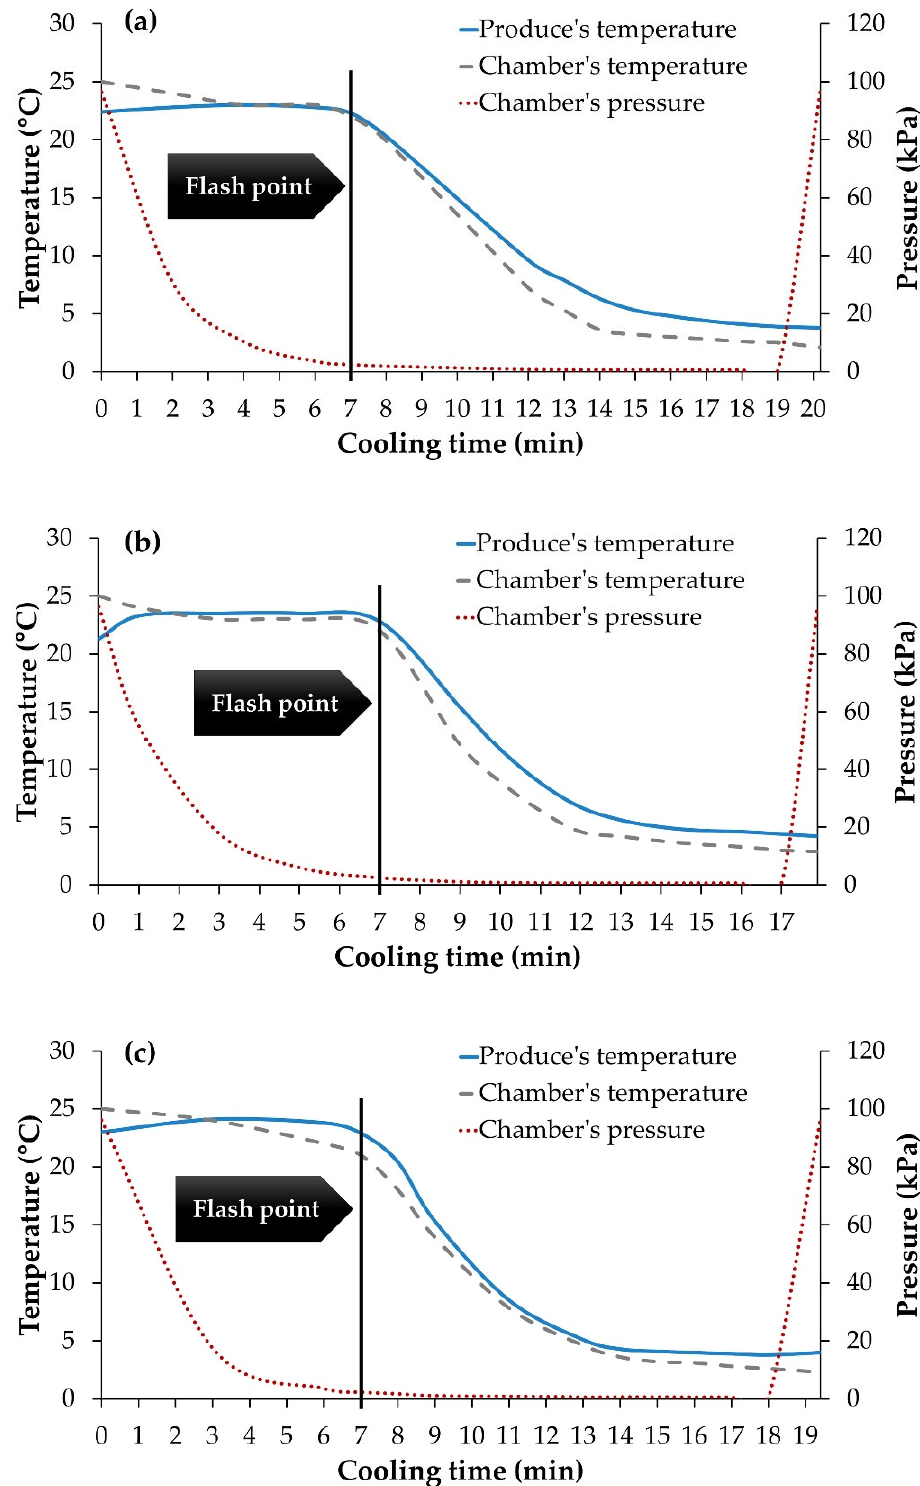
Figure 2. Cooling curve of fresh-cut frillice iceberg ( a ), romaine ( b ), and red oak leaf ( c ) lettuce, and chamber pressure and temperature changes during the vacuum precooling process.